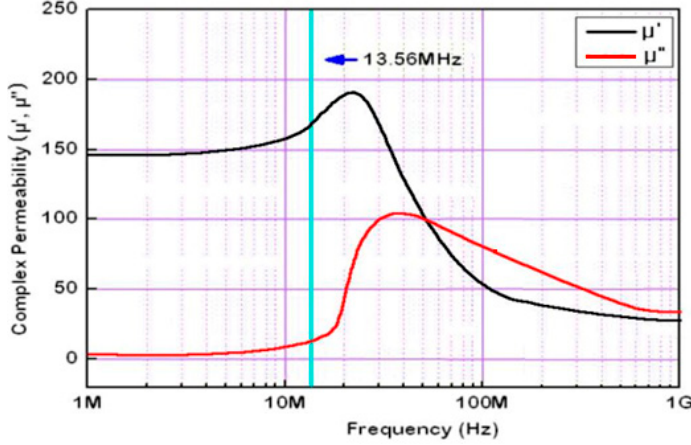
Figure 11. Magnetic permeability characteristic curves of Ni-Zn ferrite materials.